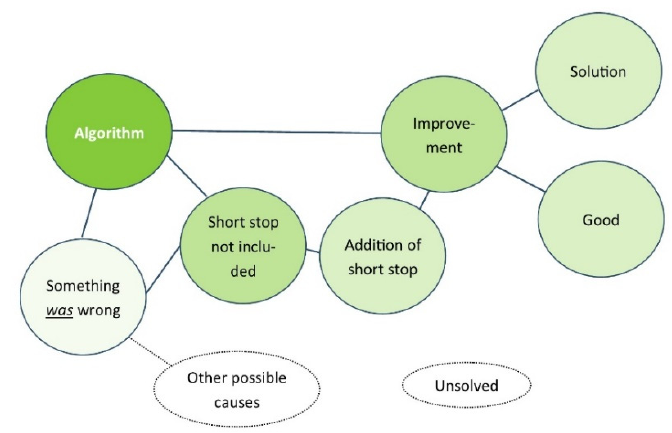
Figure 6. Associations and activation after bug fix.